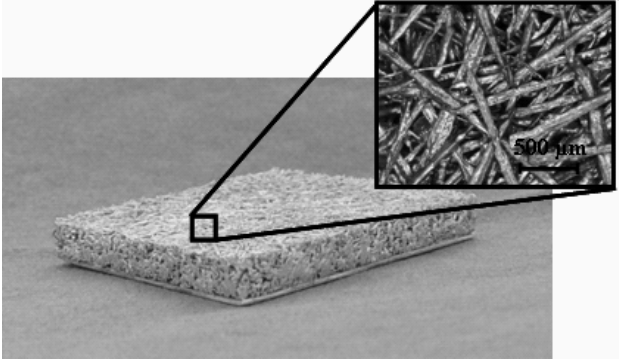
Figure 2. Sample of fiber-SAPO-34 composite material (0.03 m × 0.03 m × 0.0039 m), carrier: Al sheet of 0.4 mm